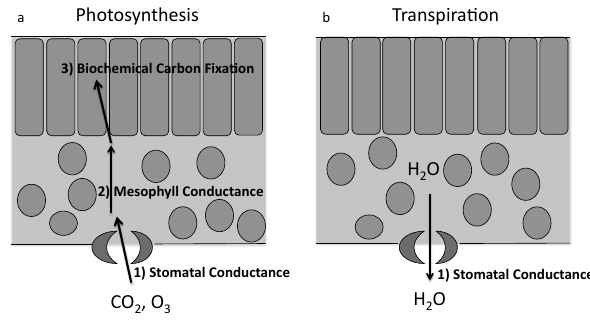
Fig. 1. An illustration of leaf cross sections. The process of photo- synthesis (a) relies on three steps: (1) CO 2 enters the leaf through the stomata, which is regulated by the size of the opening between the stomatal cells, or the stomatal conductance; (2) CO 2 travels through the intercellular spaces to the chloroplasts (mesophyllic processes); and (3) inside the chloroplasts, CO 2 is changed into sugars through biochemical carbon fixation. At the leaf-level, the process of transpiration (b) is only controlled by stomatal conduc- tance (1). Stomatal conductance is a common mechanism that con- trols both photosynthesis and transpiration, so these processes are often closely coupled and will continue to be coupled if O 3 primar- ily effects stomatal conductance. However, experimental evidence shows that O 3 damage primarily effects biochemical carbon fixa- tion (3) and mesophyllic processes (2), leading to a decoupling of photosynthesis and